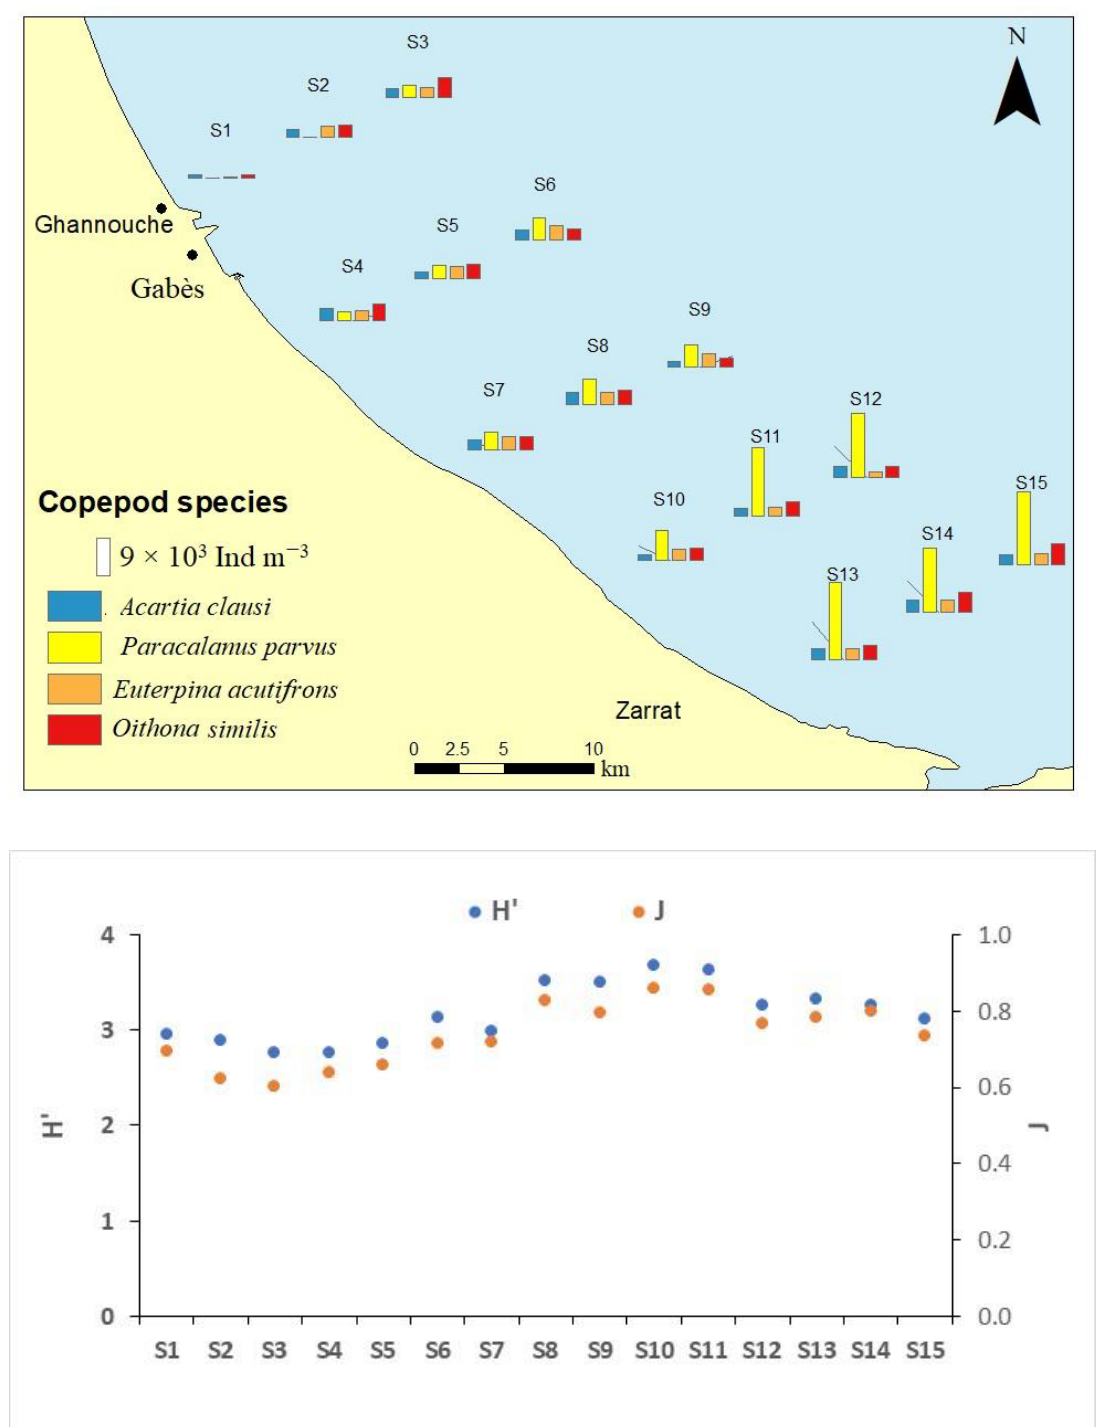
Figure 10. Spatial abundance of most important Copepoda taxa (number beside the bar indicates scale of abundance) ( top ) and diversity indices (H’ and J) ( bottom ).